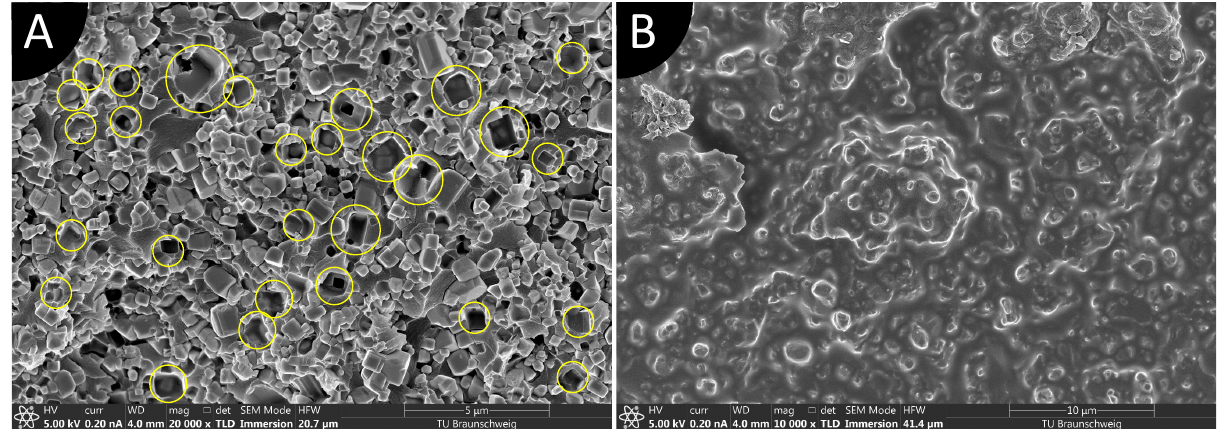
Figure 2. Microstructure of: ( A ) 30KNN6 ( × 20,000), ( B ) 30BTO13 ( × 10,000). Yellow circles show clearly visible missing